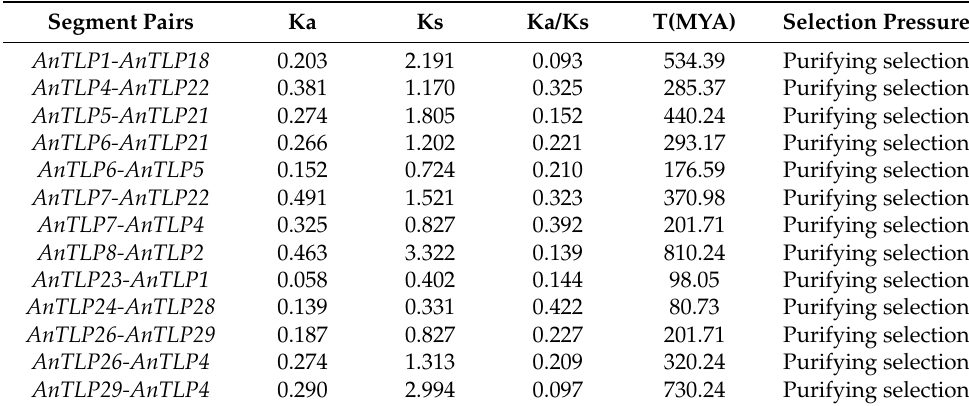
Table 2. Analysis of evolutionary selection pressure on the A. nanus TLP gene family.